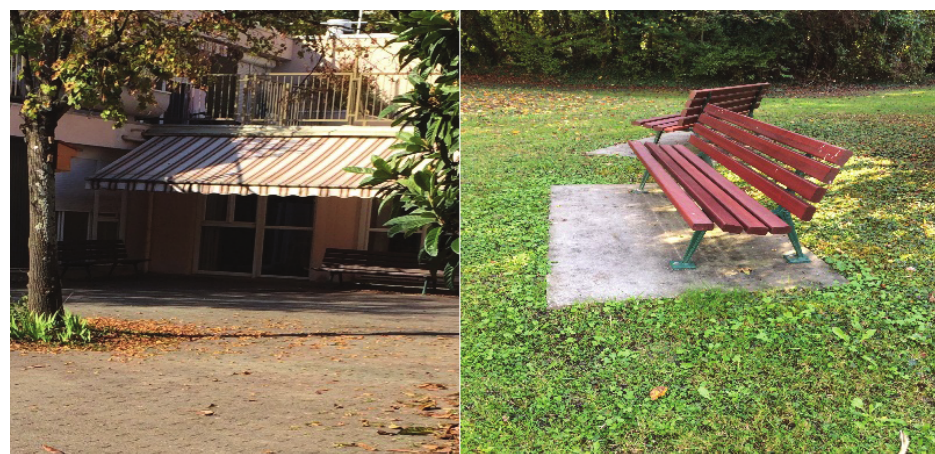
Figure 9. Benches in the studied neighbourhood. Source: the